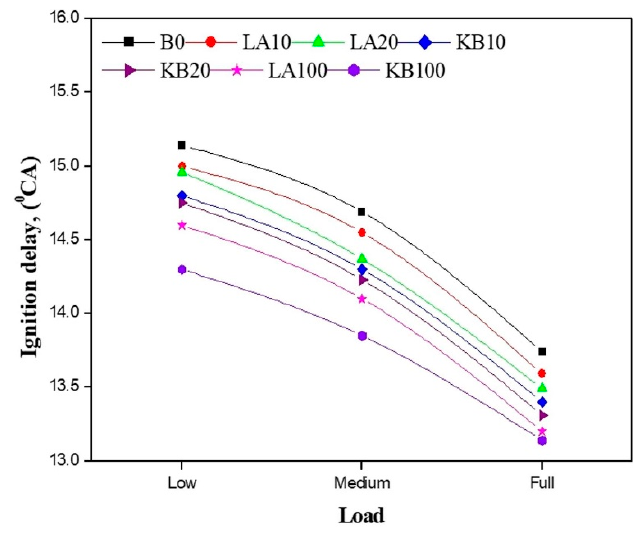
Figure 6. Effect of load on ignition delay of fuel blends [73]. Figure 6. E ff ect of load on ignition delay of fuel blends